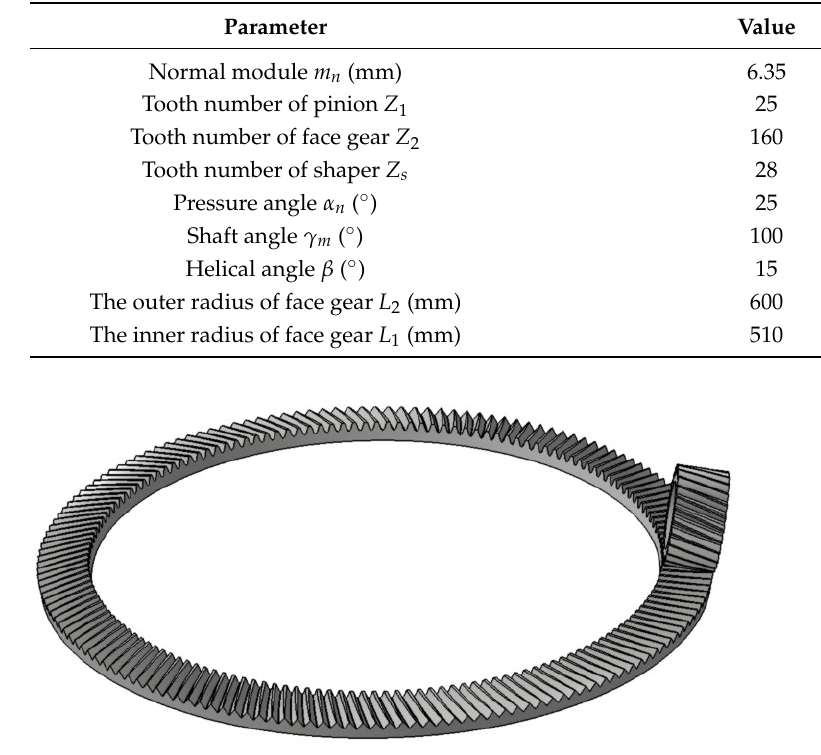
Figure 5. A 3D model of the modified helical face gear transmission.